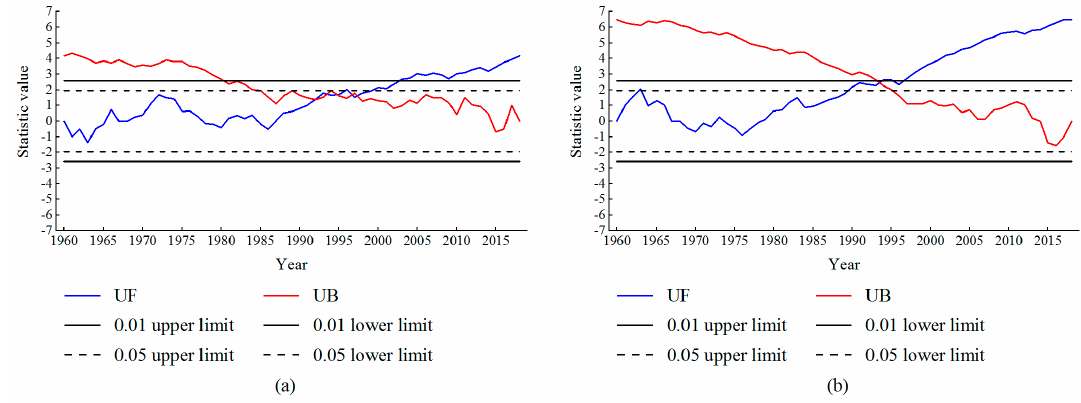
Figure 10. M-K-S test results of the annual mean precipitation ( a ) and annual mean temperature ( b ).